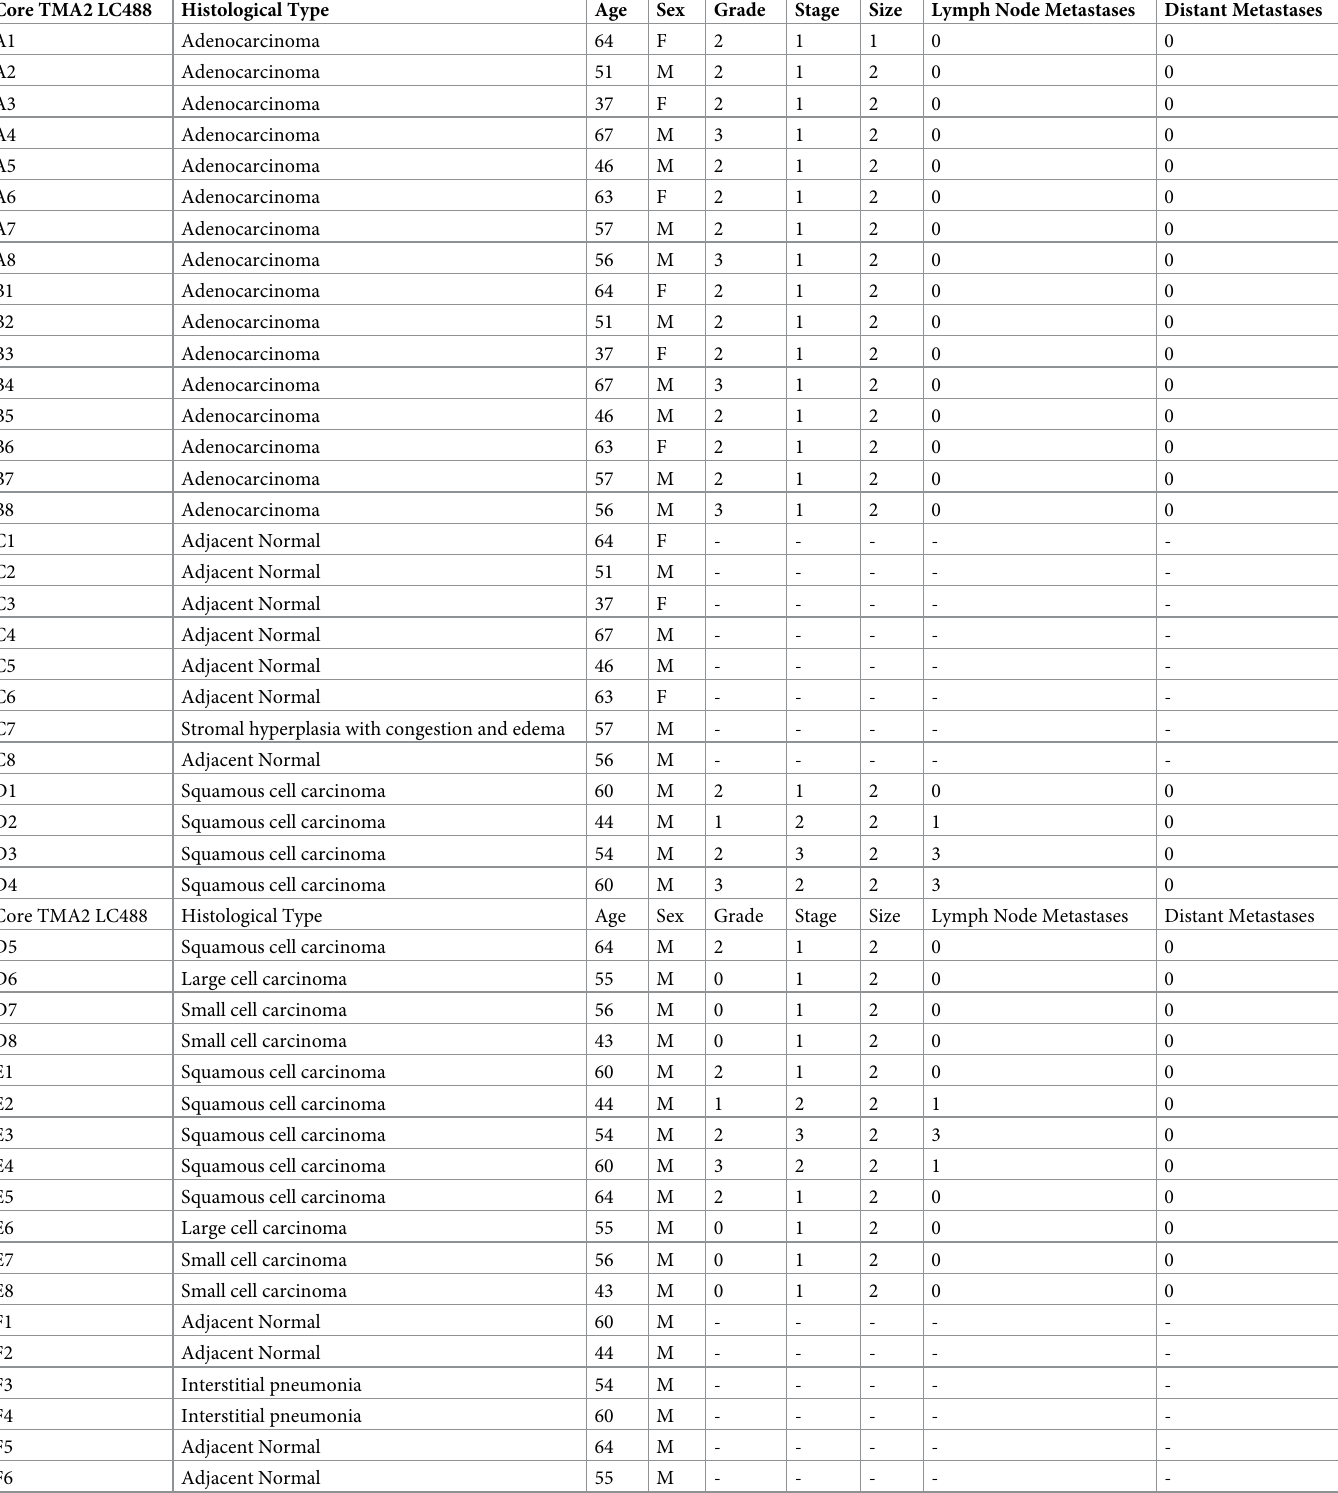
Table 2. Complete description of TMA